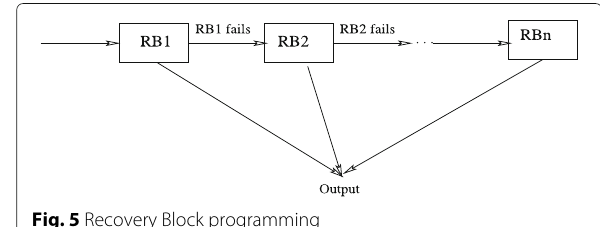
Fig. 5 Recovery Block